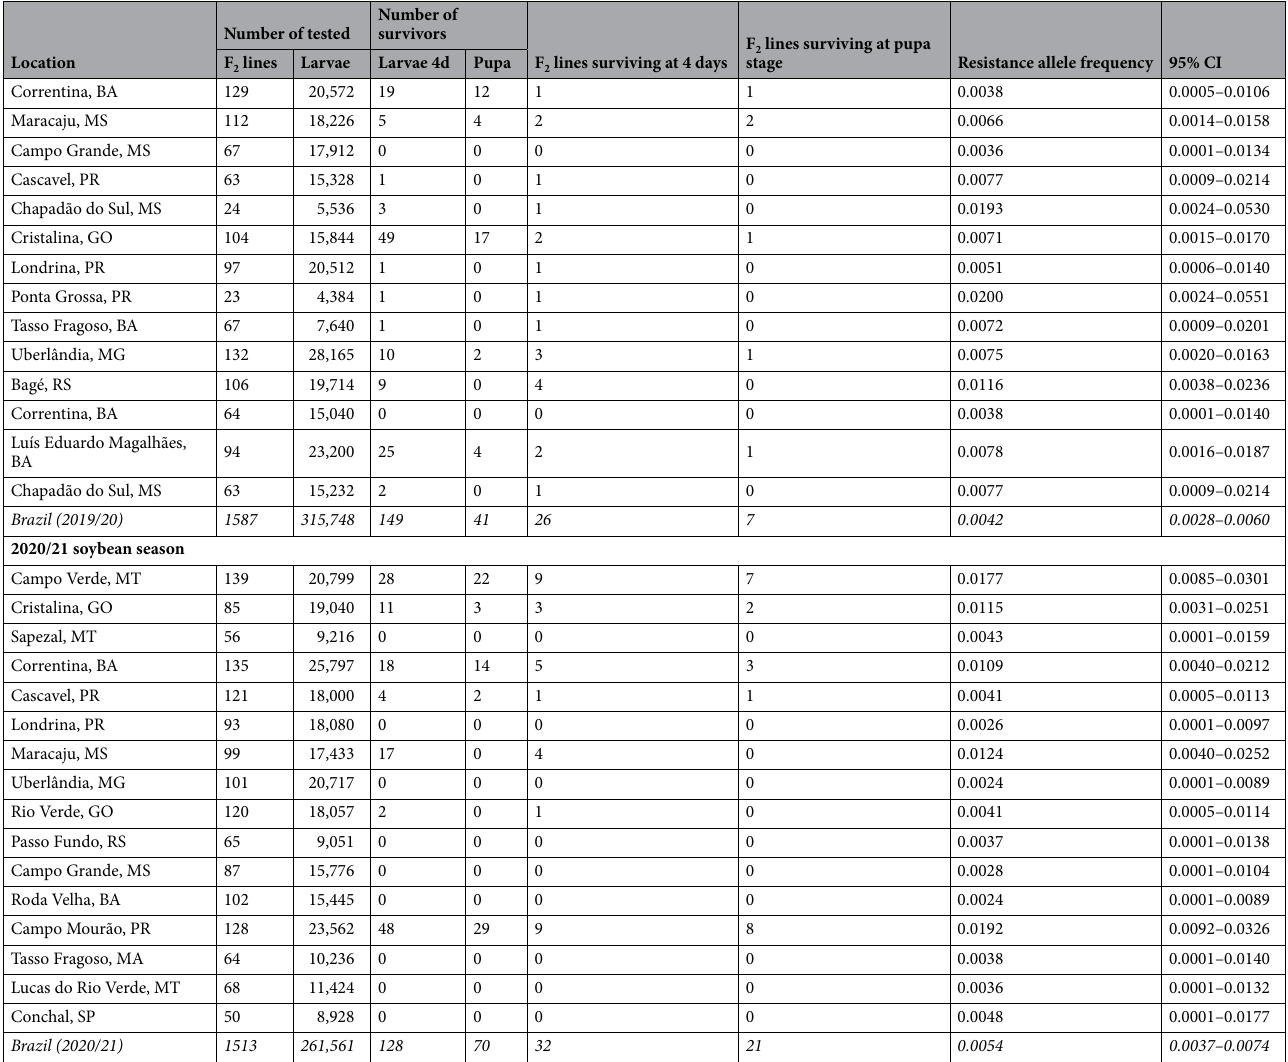
Table 1. Frequency of resistance alleles conferring resistance of C. includens to MON 87701 × MON 89788 soybean in Brazil from 2016/17 to 2020/21.